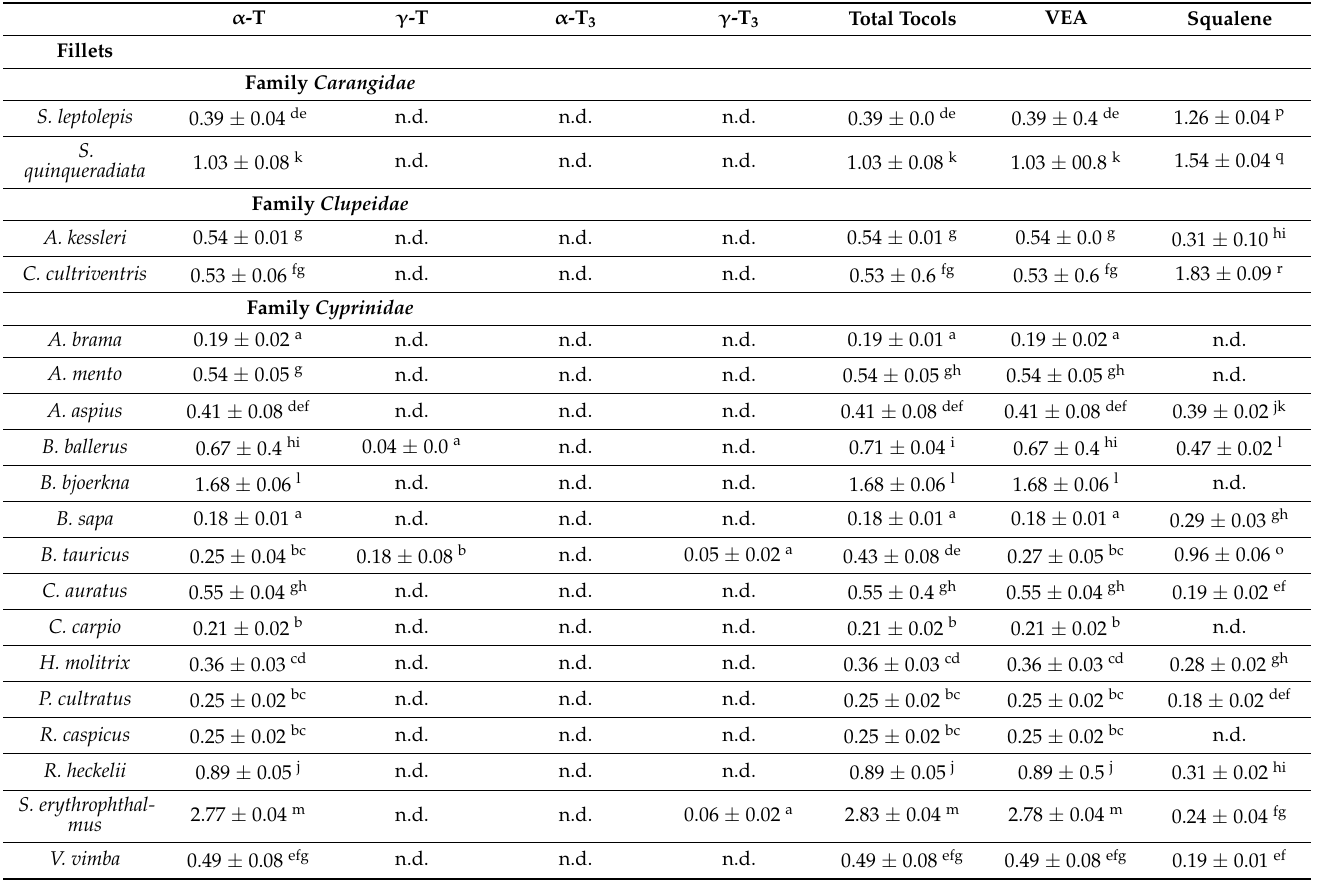
Table 3. Tocol profiles and contents, VEA, and squalene (mg/100 g) of sampled fishes and roes. Data are shown as mean value ± SD (n = 5) a